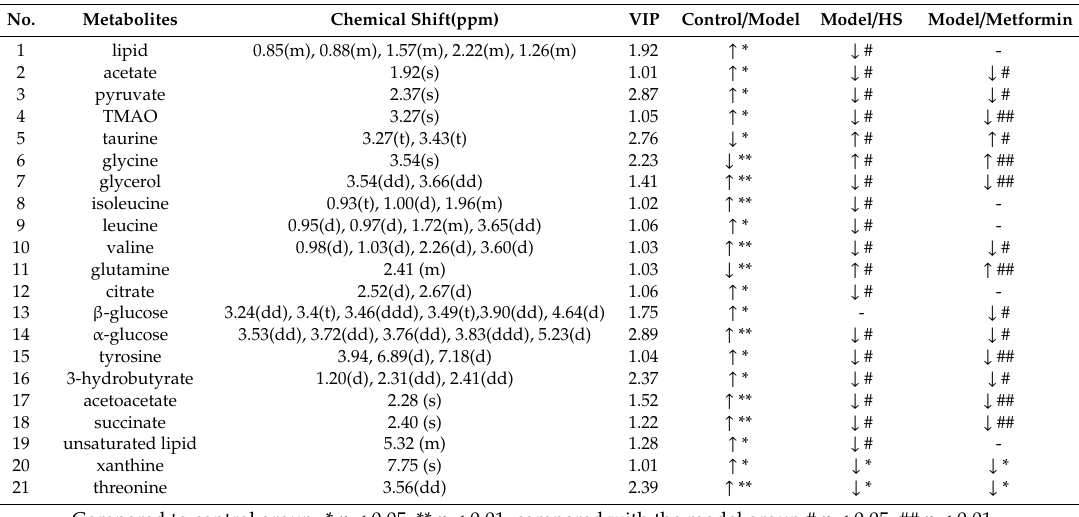
Table 1. Statistical analysis results of the main metabolites in serum.